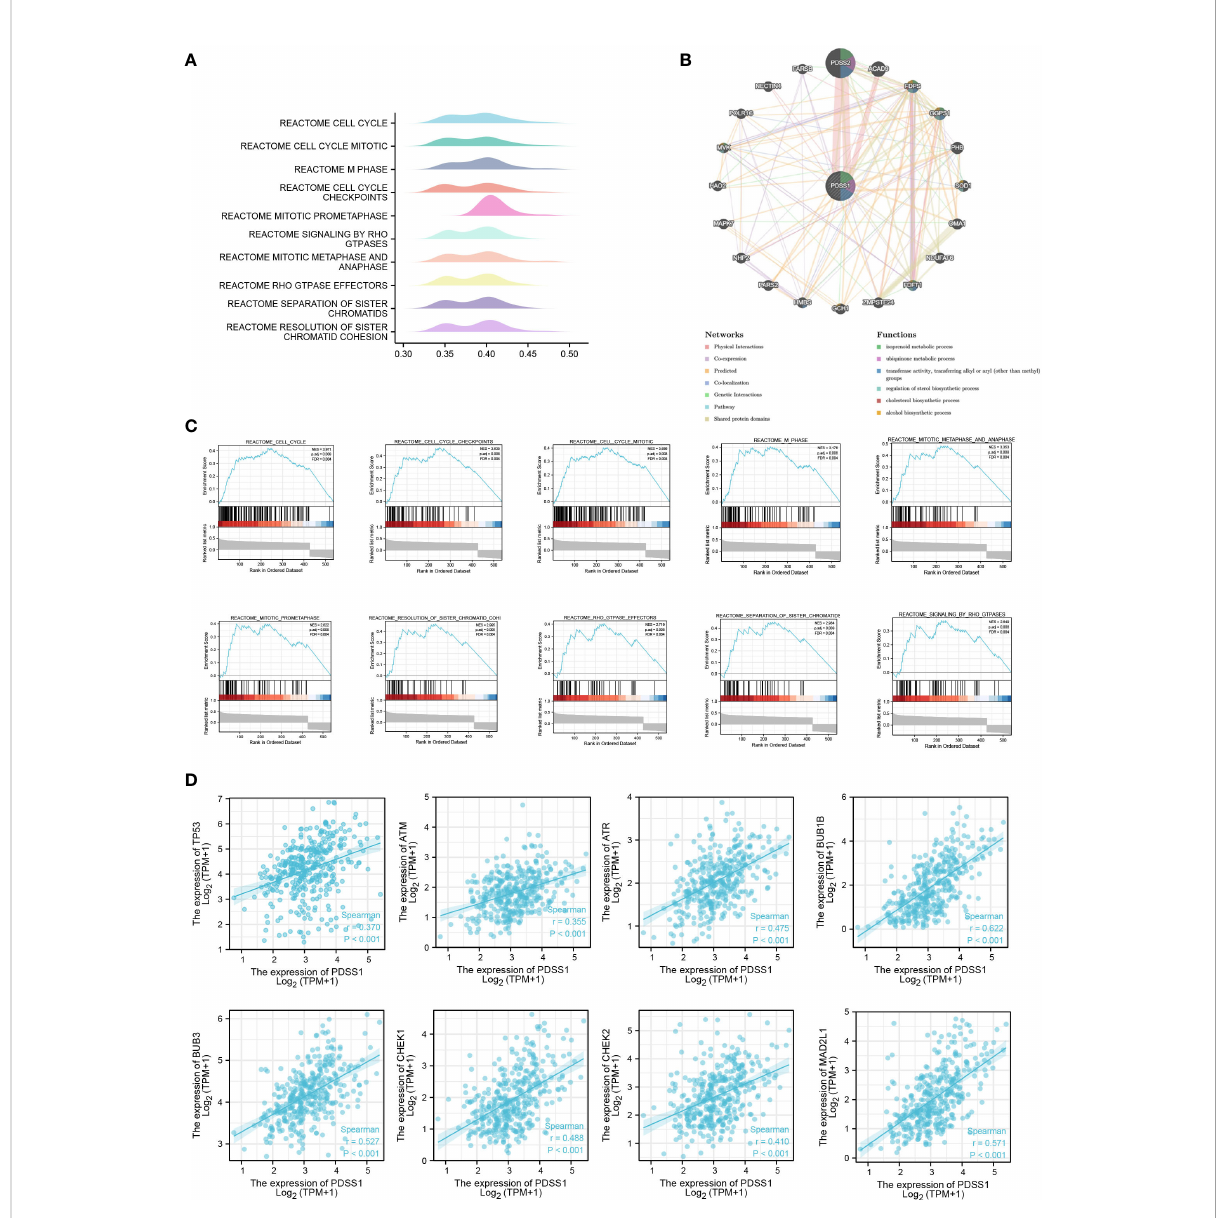
FIGURE 4 The potential PDSS1-regulated pathway. (A, C) Reactome analysis revealed the pathway enriched in PDSS1 high and low expression phenotype. (B) Protein – protein interaction (PPI) network and functional analysis indicating the gene sets enriched in the target network of PDSS1. (D) Correlation between expression of PDSS1 and cell cycle checkpoint related